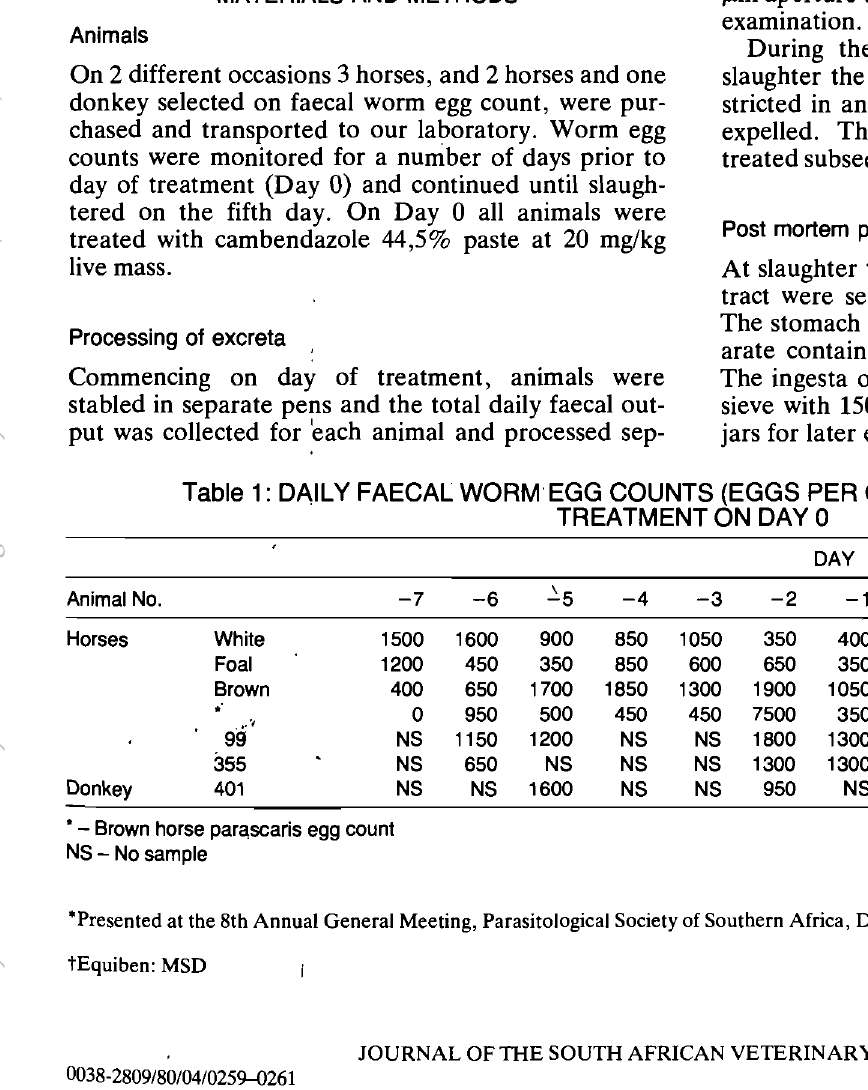
Table 1: DAILY FAECAL WORM EGG COUNTS (EGGS PER GRAM) BEFORE AND AFTER TREATMENT ON DAY